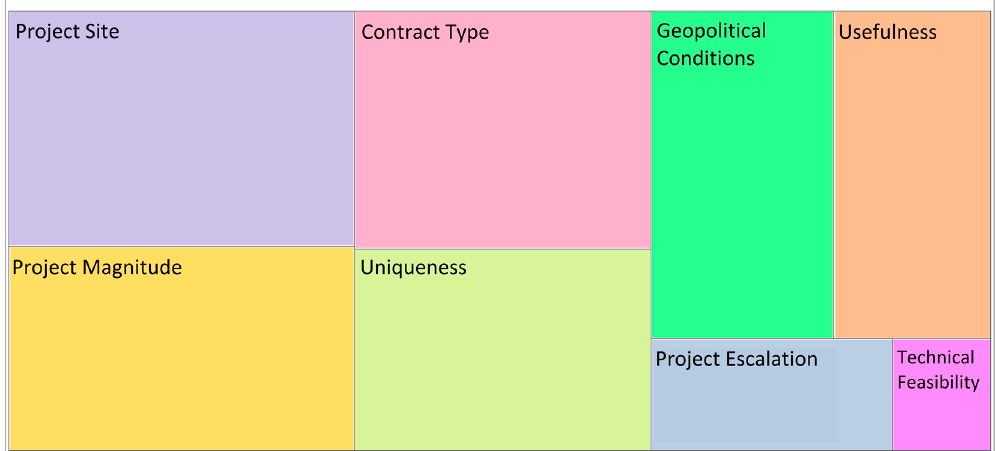
Figure 11. Hierarchy chart of project factors.